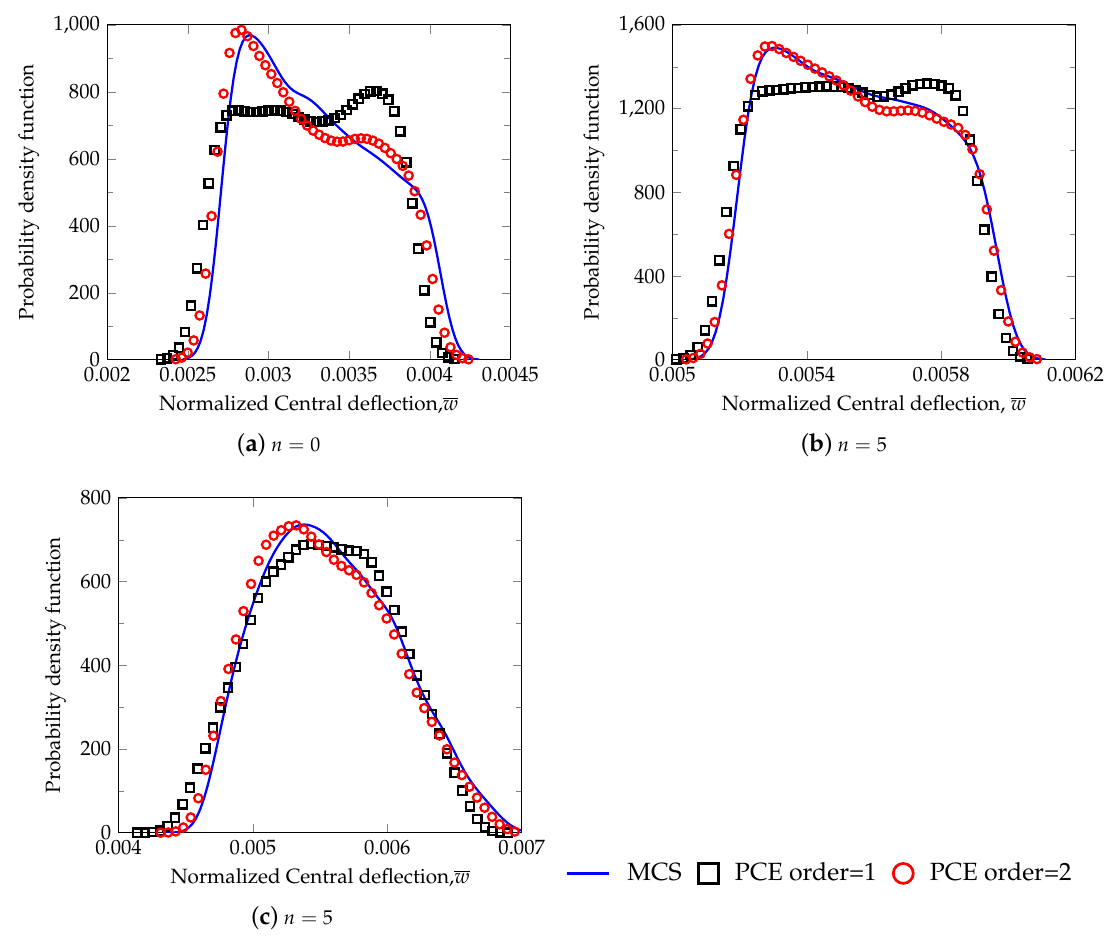
Figure 3. Variation of the probability density function as a function of normalized central deflection; assuming the Young’s modulus of ceramic as random and ( a ) n = 0, ( b ) n = 5 and ( c ) the Young’s modulus of both metal and ceramic as random with n = 5.